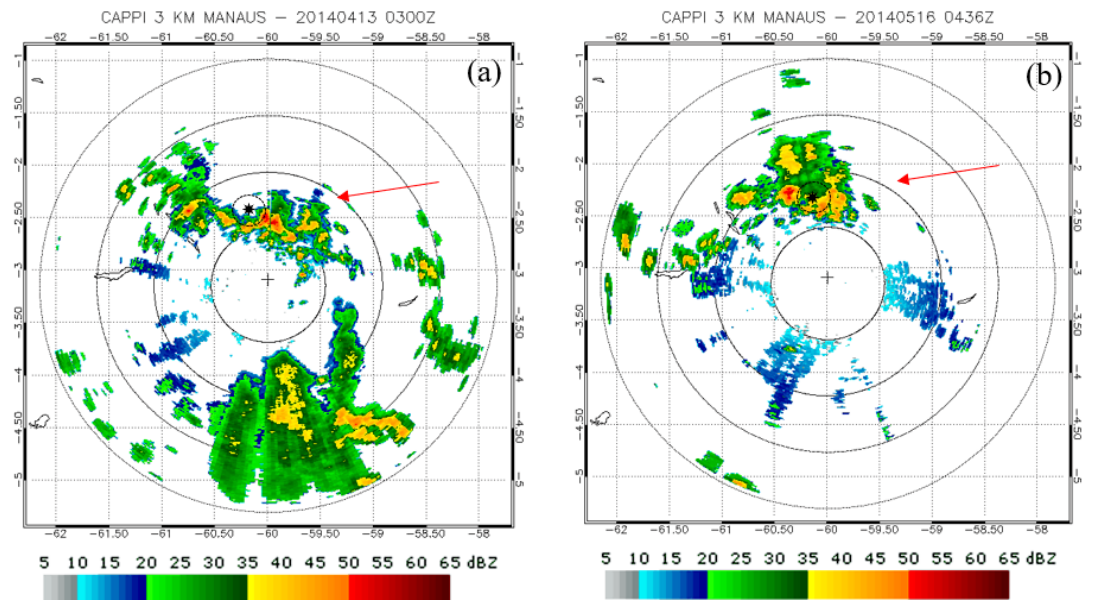
Figure 3. Radar images showing the pattern of cloud cover around the experimental site in periods during occurrences of EP in ( a ) 13 April 2014 at 03 UTC and ( b ) 16 May 2014 at 0436 UTC. The red arrow indicates the direction of the cloud motion and the black point corresponds to the approximate location of the meteorological tower K34. The color bar indicate the corrected equivalent reflectivity factor (dBz). Source: